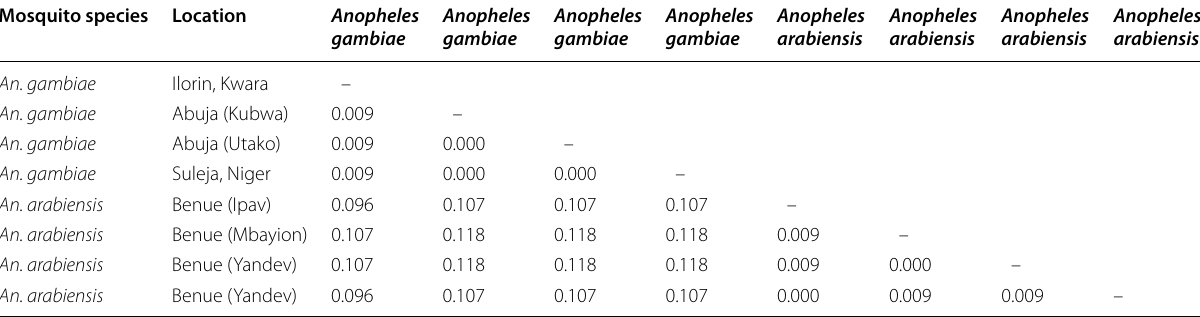
Table 4 Estimates of evolutionary divergence between the IGS region sequences of some Anopheles species used in this